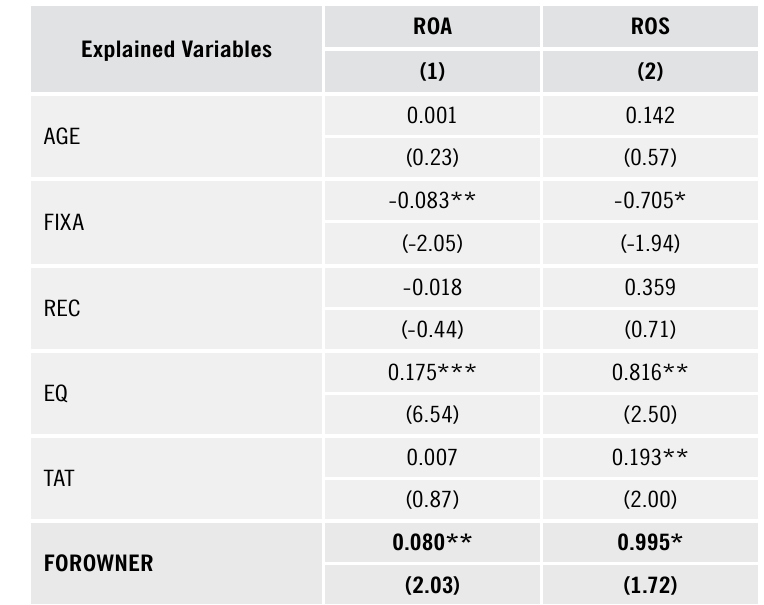
Table 9. Empirical relationship between foreign ownership and firm contemporaneous ROA &